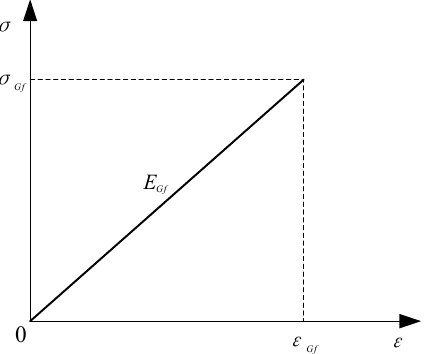
Figure 5. Constitutive model of GFRP anchor, where E Gf is the elastic modulus of GFRP, and σ Gf and ε Gf are the ultimate stress value and ultimate strain value of GFRP, respectively.